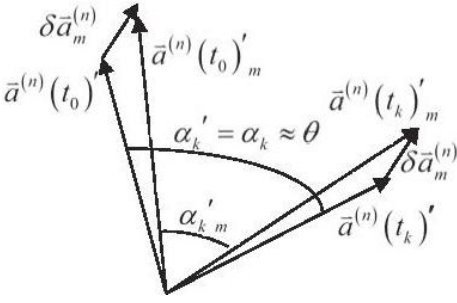
 . Figure 1 depicts this new constraint: k Figure 1. Geometric depiction of the rate-gyro-integral